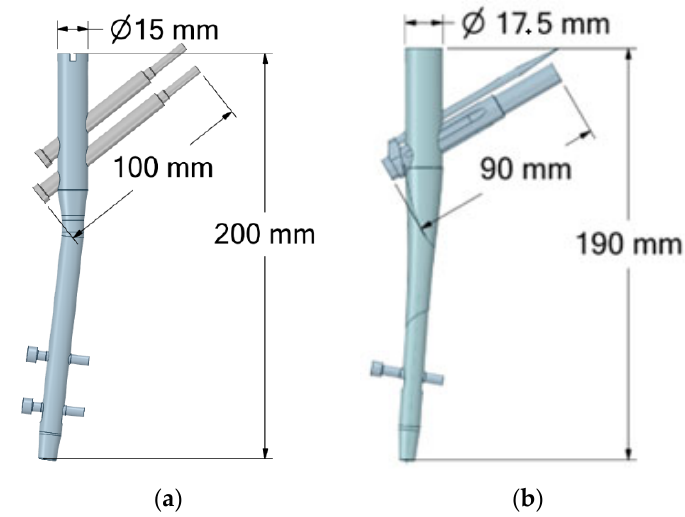
Figure 5. General dimensions of examined implants. ( a ) Medin; ( b ) Tantum. Table 2. Cannulated nails under investigation.